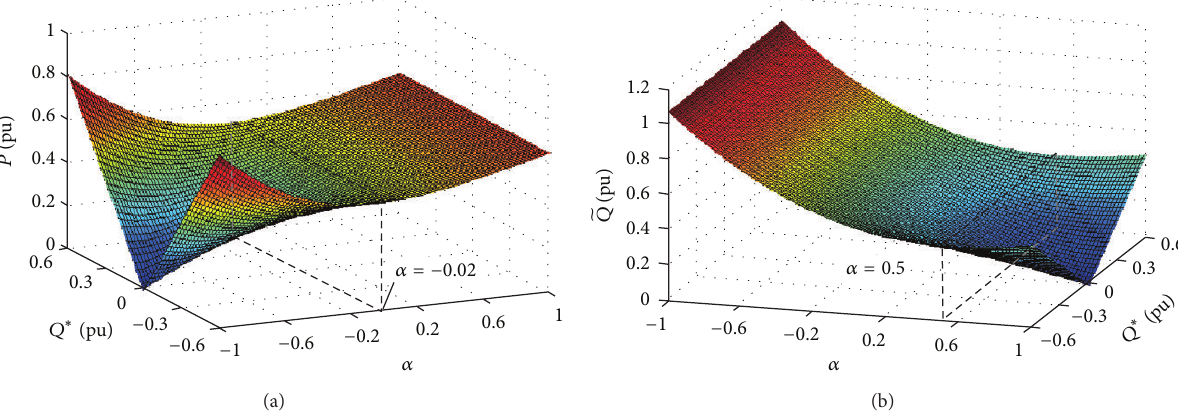
Figure 4: Three-dimensional mesh of active and reactive power fluctuation magnitudes. (a) Amplitudes of active power fluctuation. (b) Amplitudes of reactive power fluctuation.